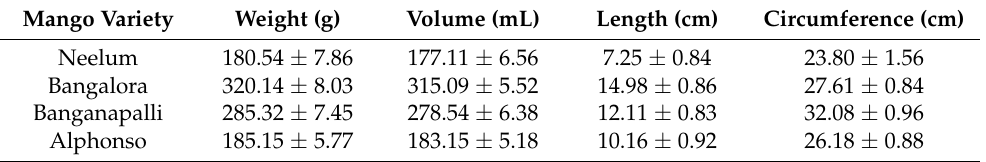
Table 1. Average fruit weight, volume and size of the different mango varieties used for the experiment. Mango Variety Weight